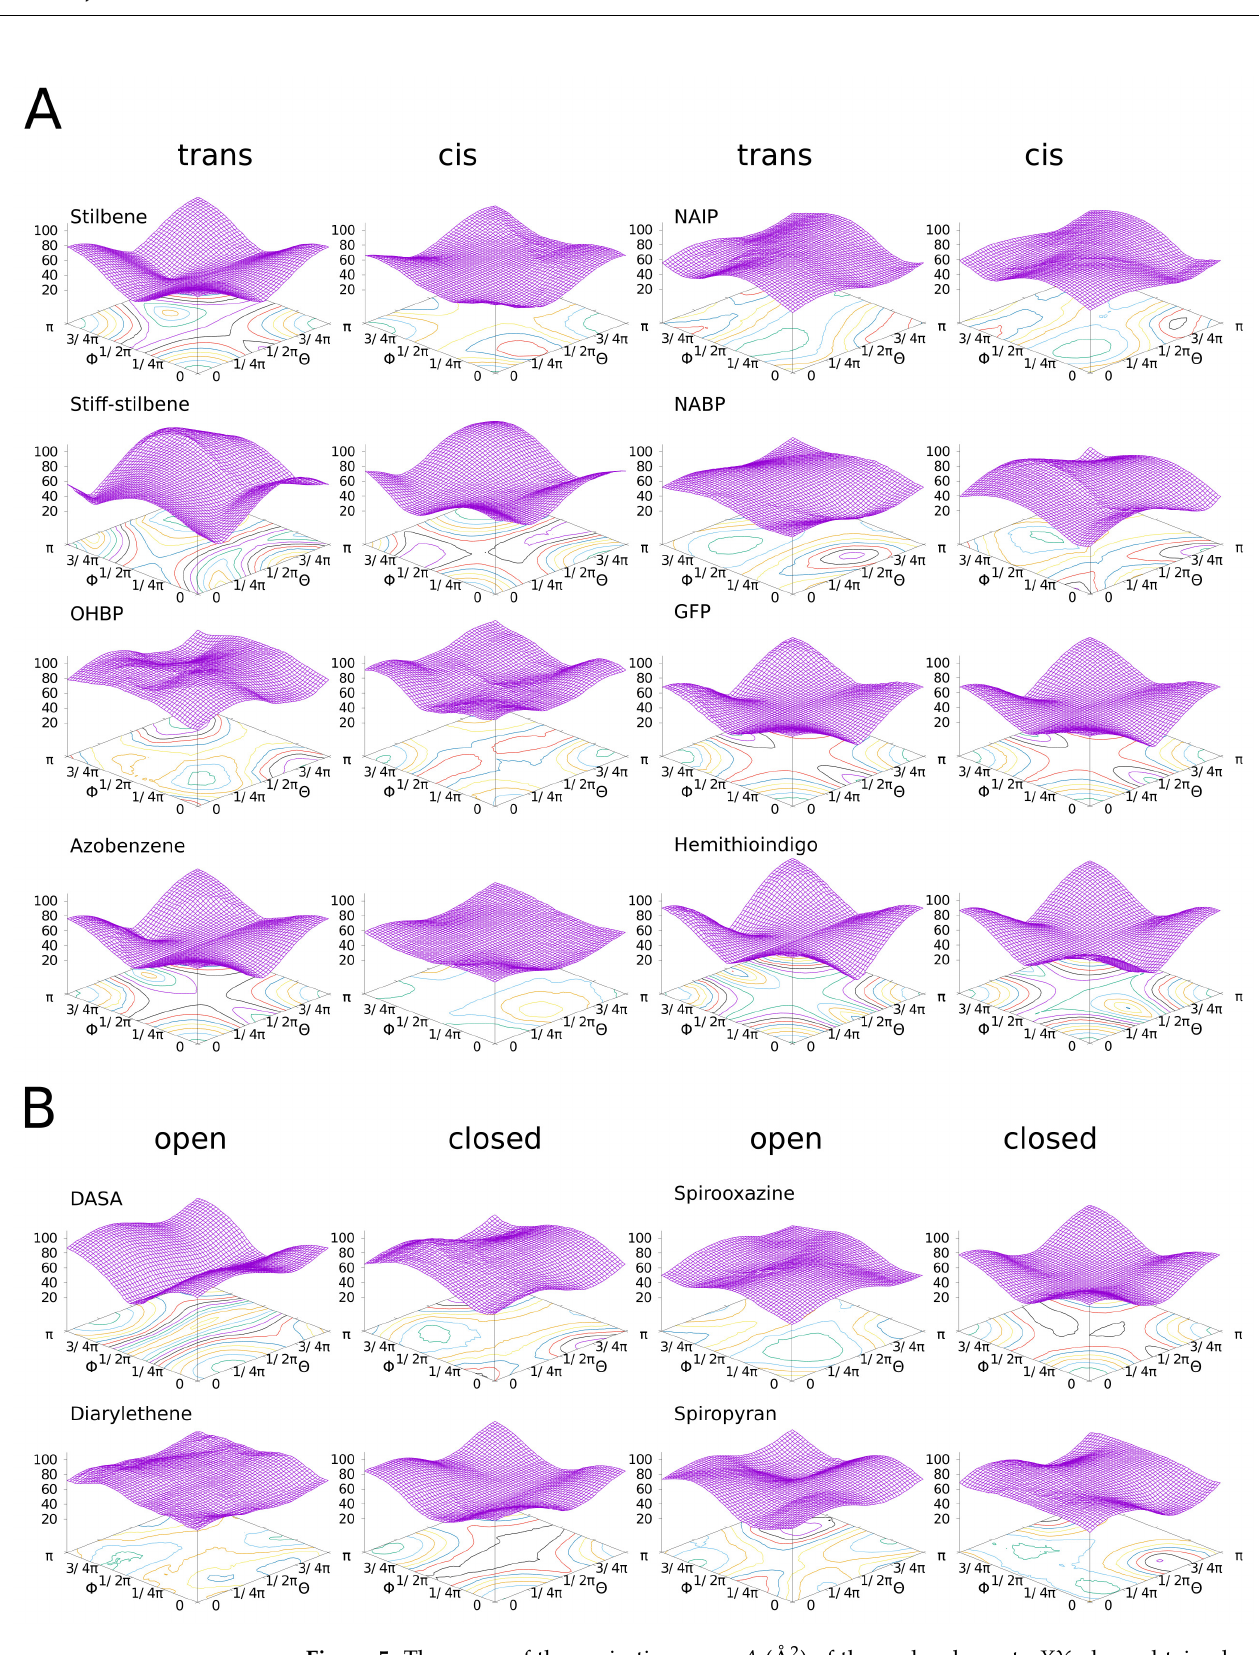
Figure 5. The space of the projection areas A (Å 2 ) of the molecules onto XY plane obtained upon scanning of the projection area upon rotation of the molecule over Θ and Φ . ( A ) E/Z-switches. ( B )